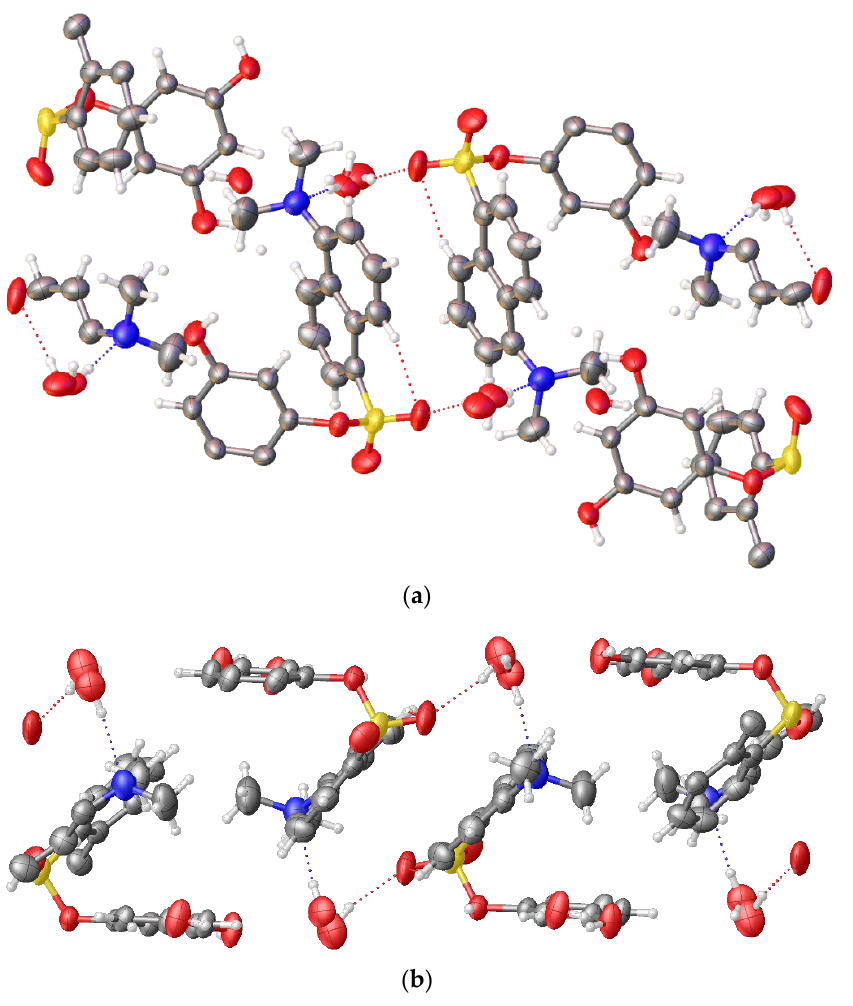
Figure 3. Packing images of sensor R1: ( a ) front view and ( b ) side view. Table 2. Selected bond lengths (Å), bond angles (°) and torsion angles (°) in sensor R1. Sensor R1